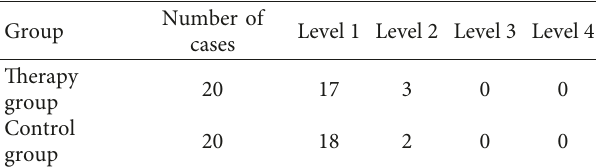
Table 2: Two groups of treatment comparisons ( n ). Group